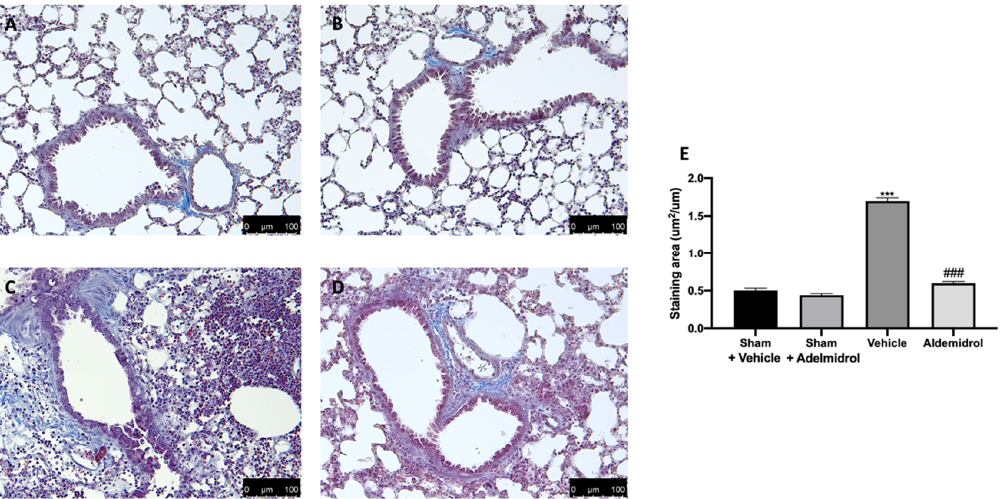
Figure 6. Effect of adelmidrol on Masson’s trichrome staining: Sham+vehicle ( A ), sham+adelmidrol ( B ), vehicle ( C ), adelmidrol ( D ), and staining area ( E ). *** p < 0.001 vs. sham+vehicle, and ### p < 0.001 vs. vehicle.